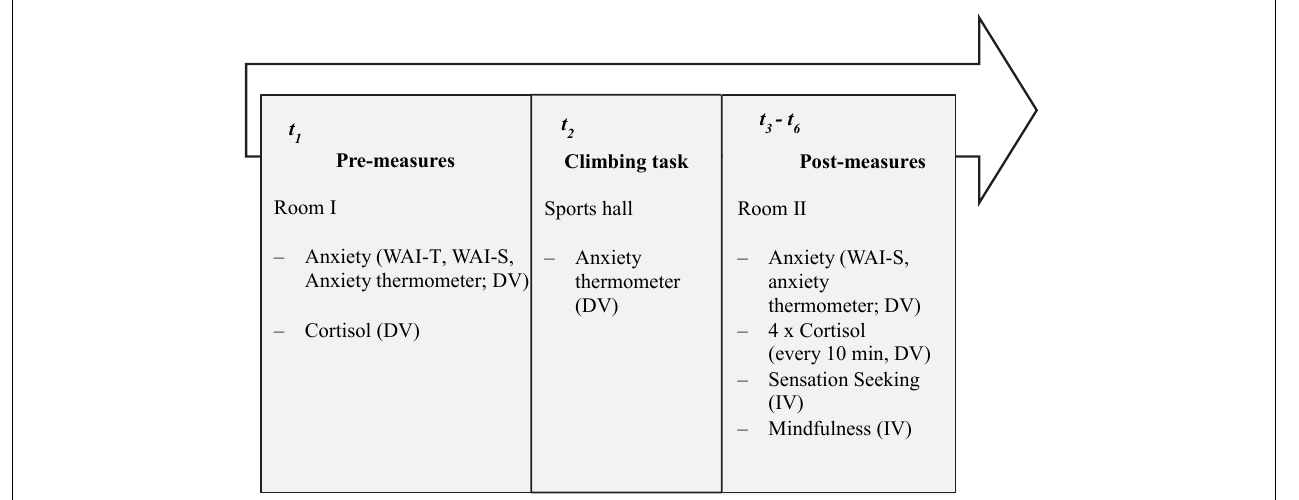
FIGURE 1 | Graphical summary of the procedure, measures, and measurement points. IV: independent variable, DV: dependent